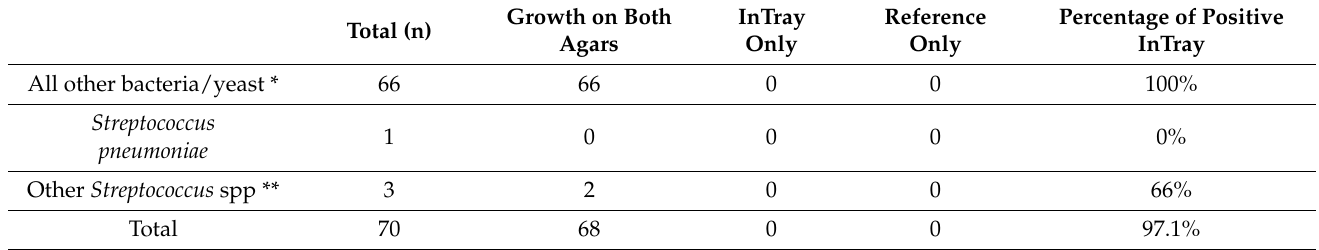
Table 4. Results of the clinical evaluation study expressed in terms of percentage of